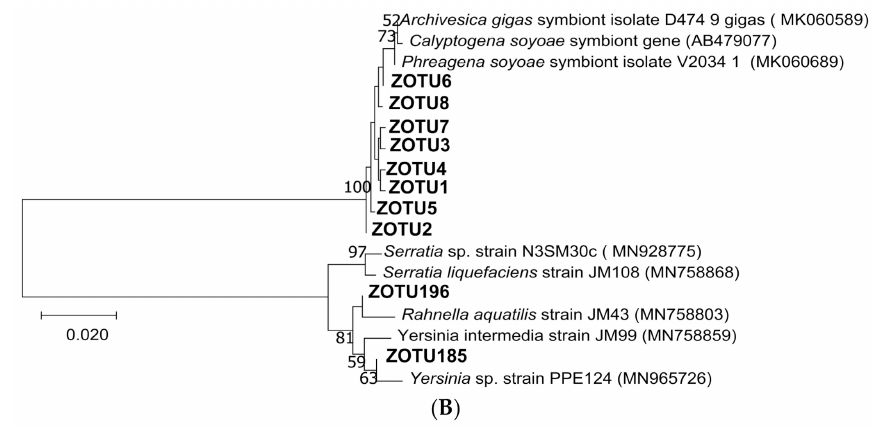
Figure 5. Phylogenic tree of the gill-associated microbes in G. haimaensis ( A ) and A. marissinica ( B ) for their top 10 high abundance ZOTUs (zero-radius operational taxonomic units) and their reference sequences, respectively, inferred from the Neighbor-Joining (NJ) analysis. The ZOTUs in ( A ) indicated the top 10 ZOTUs in G. haimaensis , and the ZOTUs in ( B ) indicated the top 10 ZOTUs in A. marissinica . The bootstrap values ( > 50%) of relevant nodes are shown based on 1000 replicates. Sequences from this study are shown in bold. Scale bars: 2% of the estimated sequence divergence.